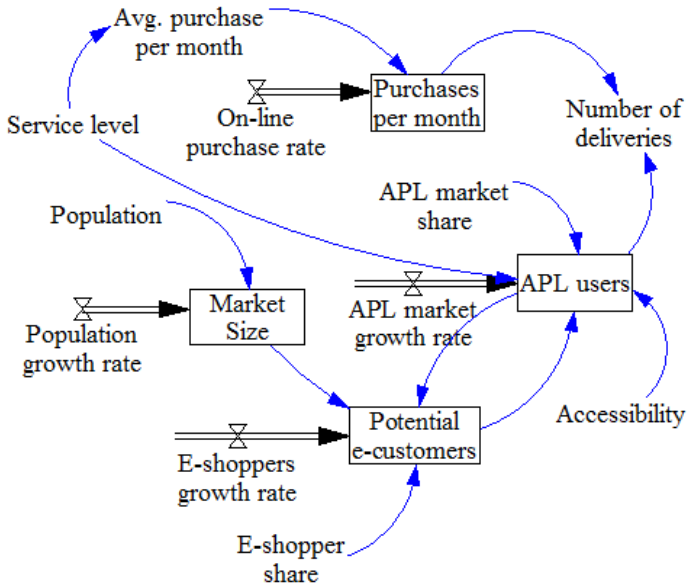
Figure 6. The APL systems stock-flow diagram.